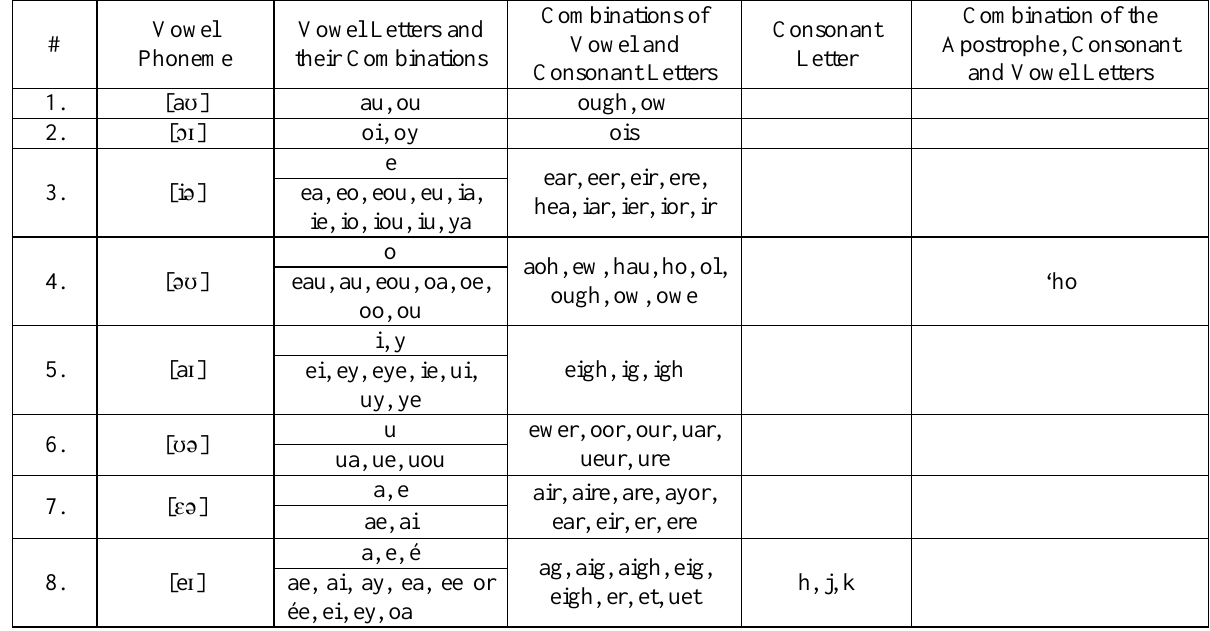
Table 1 – Ways of Graphical Spelling of